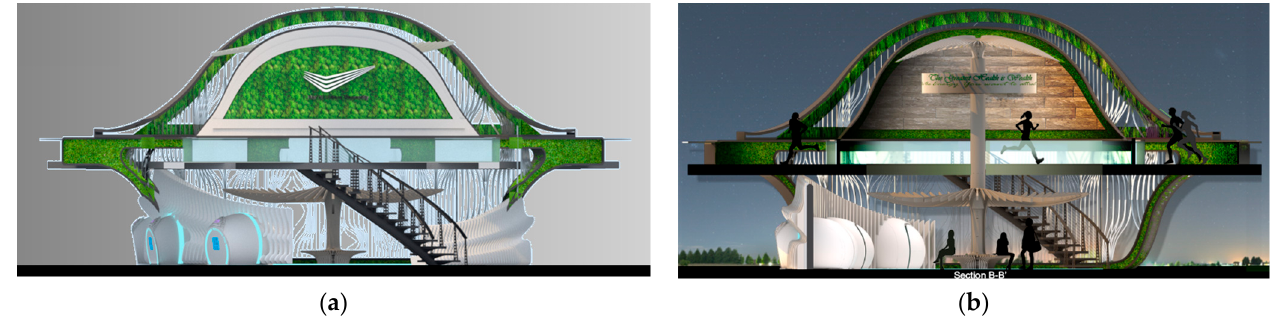
Figure 18. ( a ) Right side elevation; ( b ) right side section (designed by the authors).